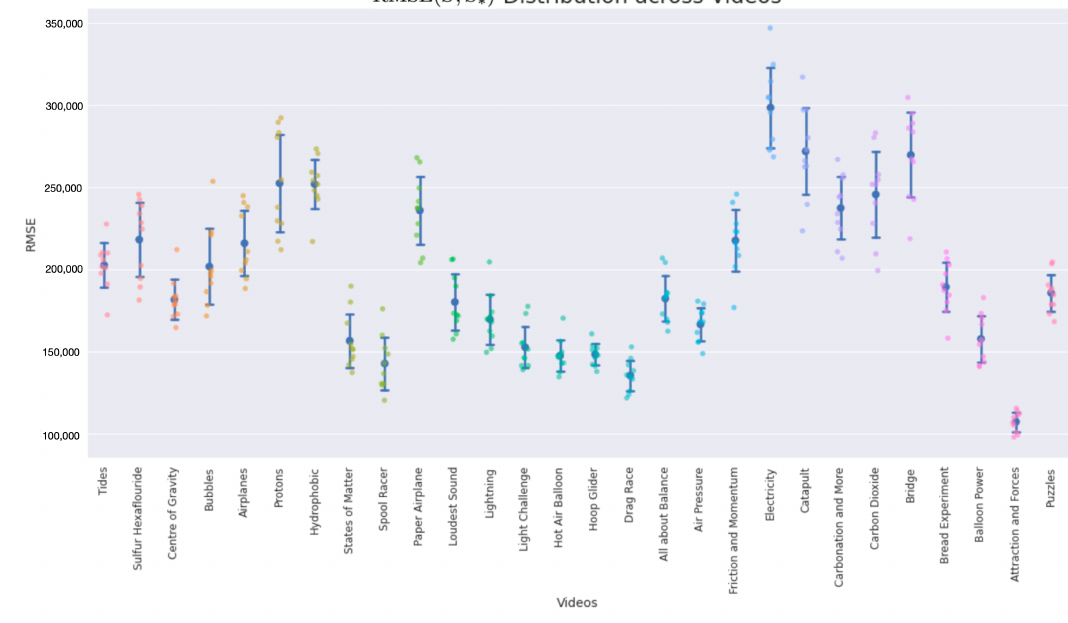
) standard deviation and mean. ∗